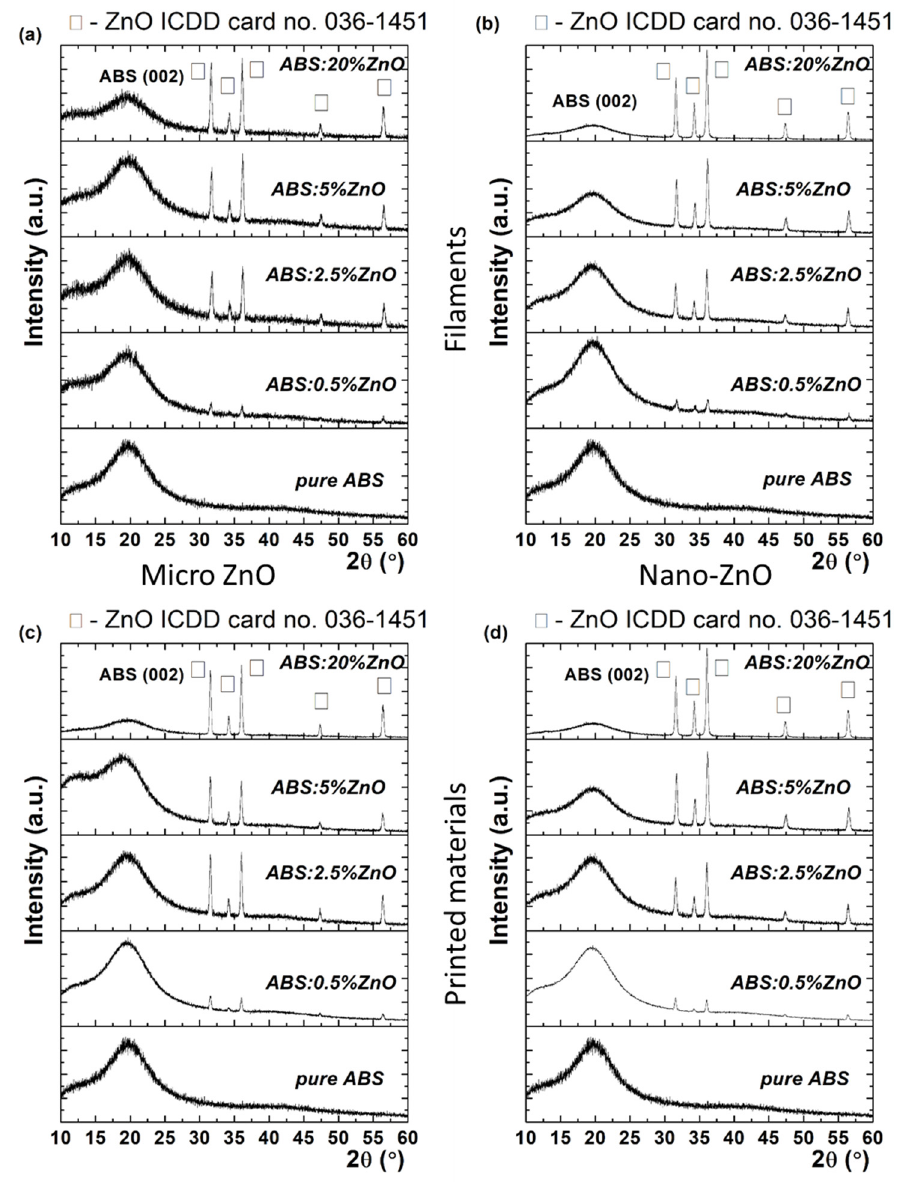
Figure 3. XRD patterns of micro- ( a ) and nano-ZnO-ABS ( b ) filaments, micro- ( c ) and nano-ZnO-ABS ( d ) printed materials, as well as for pure ABS.